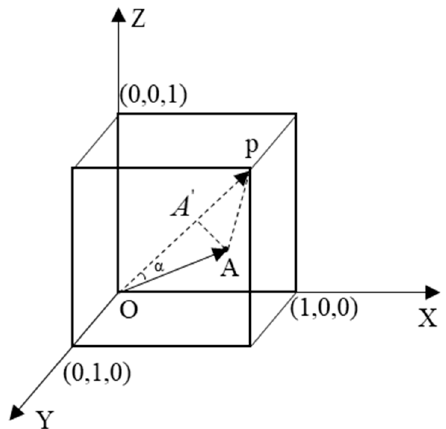
Figure 2. Three-dimensional intensive urban spatial land use model.